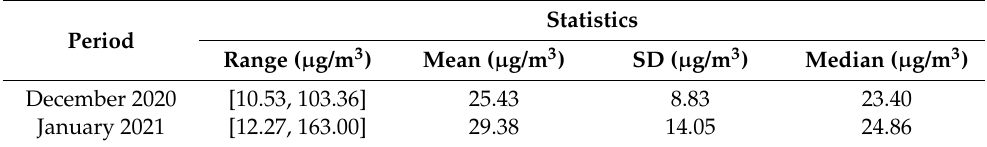
Table 3. Summary statistics of 15-min average PM 2.5 concentrations data over two-month period.